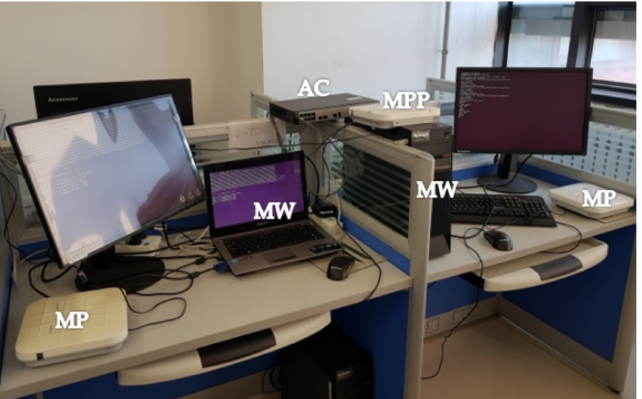
Figure 9. Components and configuration of the system. MP: mesh point, MPP: mesh portal point, MW: middleware, and AC: access controller. Table 2. Configuration of the mesh